Question: Write a single sentence explaining what this figure depicts.
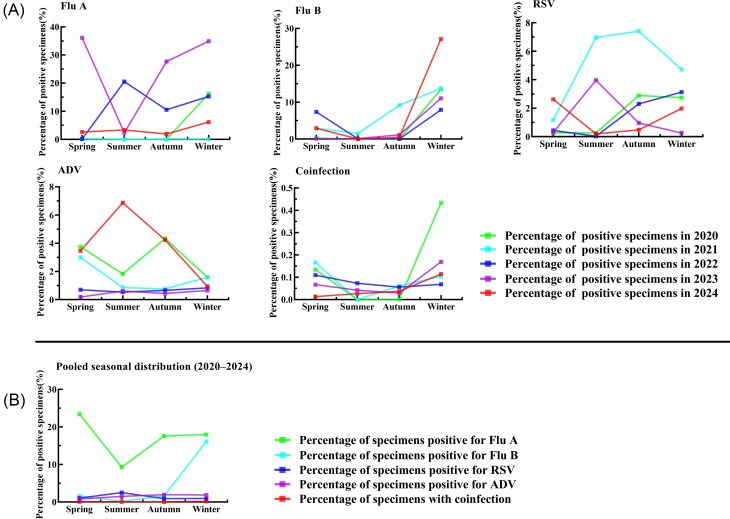
Answer: Seasonal patterns of four major respiratory viruses and coinfections from 2020 to 2024. (A) Seasonal distribution of positivity rates by year (2020–2024). Subpanels show Flu A, Flu B, RSV, ADV, and Coinfection. Each line represents one study year. (B) Pooled seasonal distribution (2020–2024). Each line represents the pooled seasonal distribution of positivity rates across the entire 5-year study period for Flu A, Flu B, RSV, ADV, and coinfections.